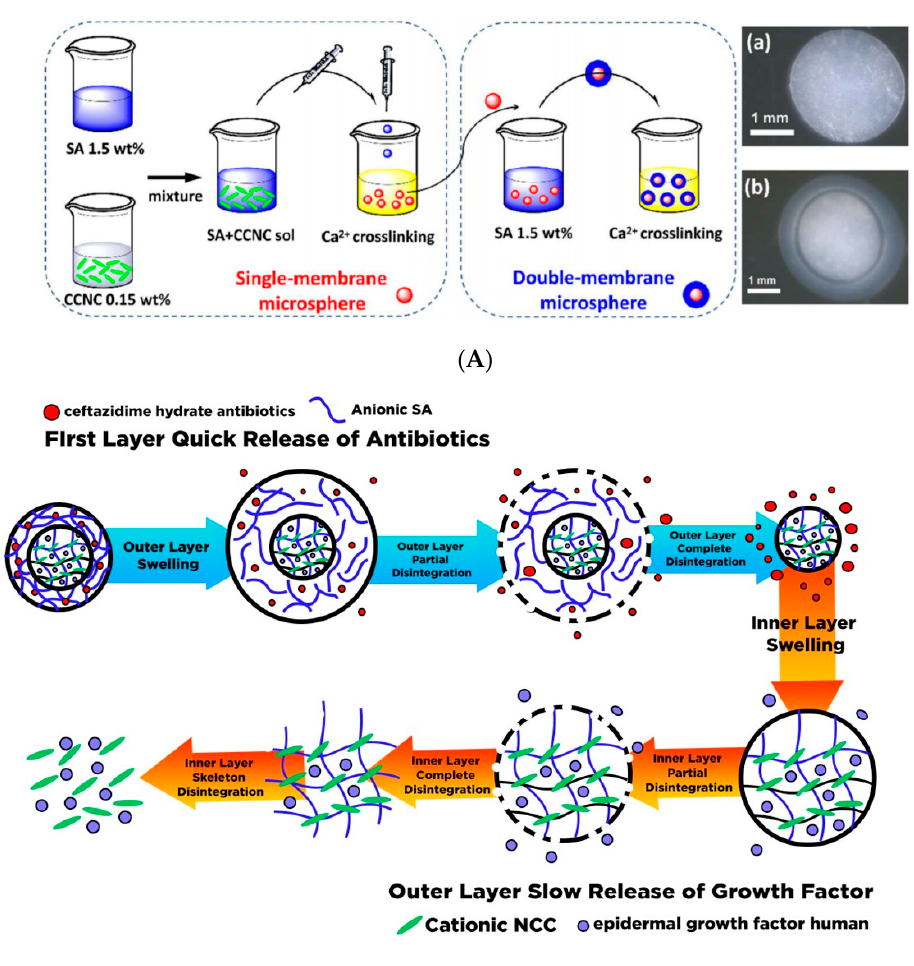
Figure 10. ( A ) The route fabrication of single membrane and double-membrane microsphere hydrogel with its optical microscope of single membrane SA/CNCC microsphere hydrogel and SA/CNCC double-membrane microsphere hydrogel (this figure is reprinted with permission from ref. [177]. Copyright © 2016 American Chemical Society); ( B ) schematic illustration of dual drug release mechanism from a double-layer membrane hydrogel constructed from Cationic NCC and Alginate (this figure is redrawn from Lin et al. [177]. Copyright © 2016 American Chemical Society).